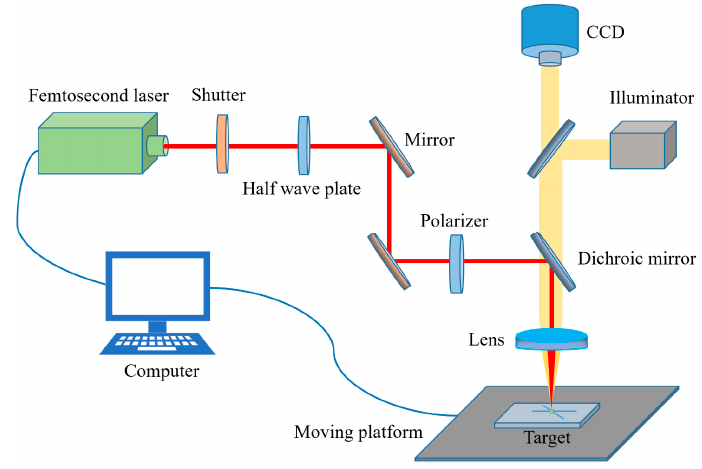
Figure 1. Schematic diagram of the femtosecond laser irradiation system.